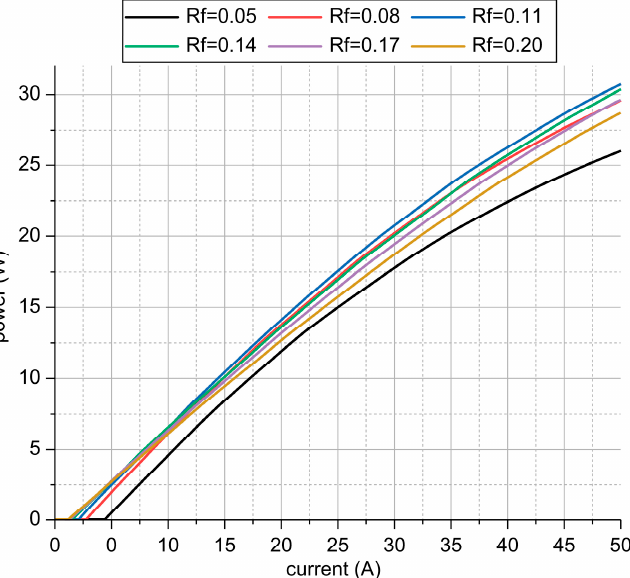
Figure 4. PI features simulated at different front optical facet reflectivity values (for a cavity length of 2 mm).